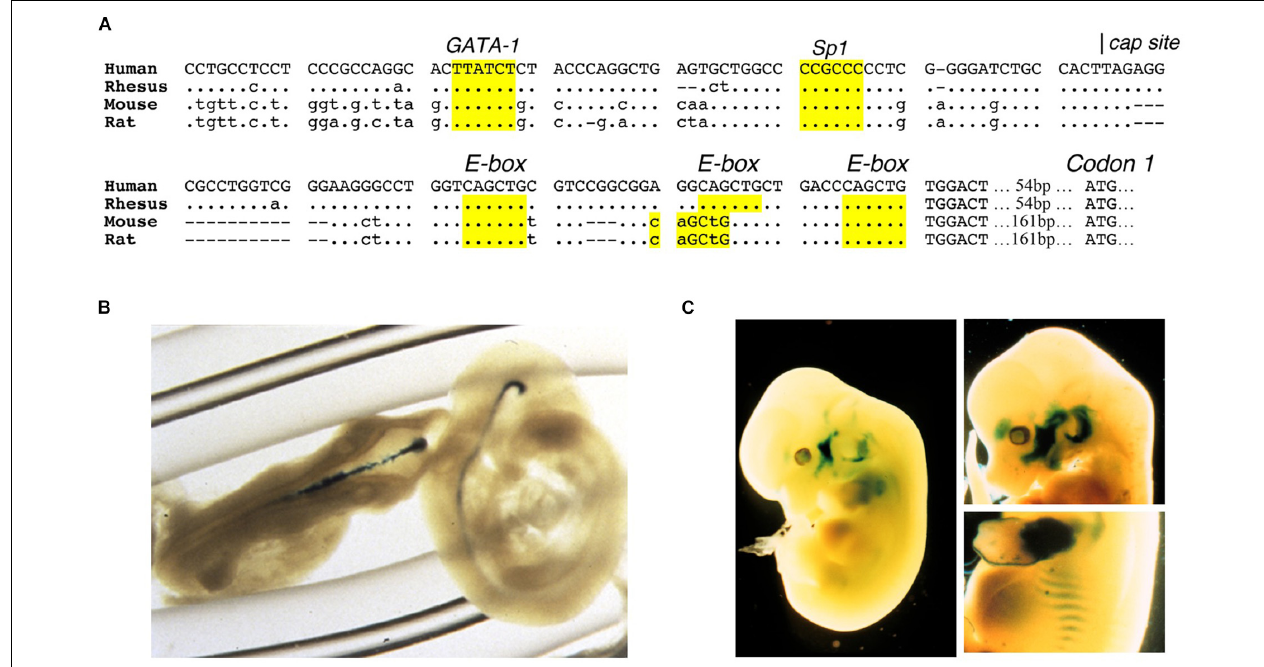
FIGURE 2 | Expression of EPOR reporter gene in transgenic mice. (A) The proximal promoter region of the human EPOR gene extending to the translation start site with ATG at +135 in the human EPOR gene, contains conserved regulatory binding sites for GATA proteins (AGATAA) and Sp1 (CCGCCC), and 3-E-boxes (CAGCTG) in the 5 (cid:48) untranslated transcribed region that can bind basic-helix-loop-helix transcription factors such as erythroid TAL1 and skeletal muscle transcription factors Myf5 and MyoD. (B) Transgenic mice containing the human EPOR proximal promoter region extending 1778 bp 5 (cid:48) of the transcription start site driving the β -galactosidase reporter gene shows EPOR expression in the embryonic brain at embryonic day E9.5 (from Liu et al., 1997, with permission). (C) Reporter gene expression at embryonic day 12.5 (left) and embryonic day 13.5 (right) in the visceral arches, base of limbs, intercostal rib regions, and fetal liver (from Ogilvie et al., 2000, with